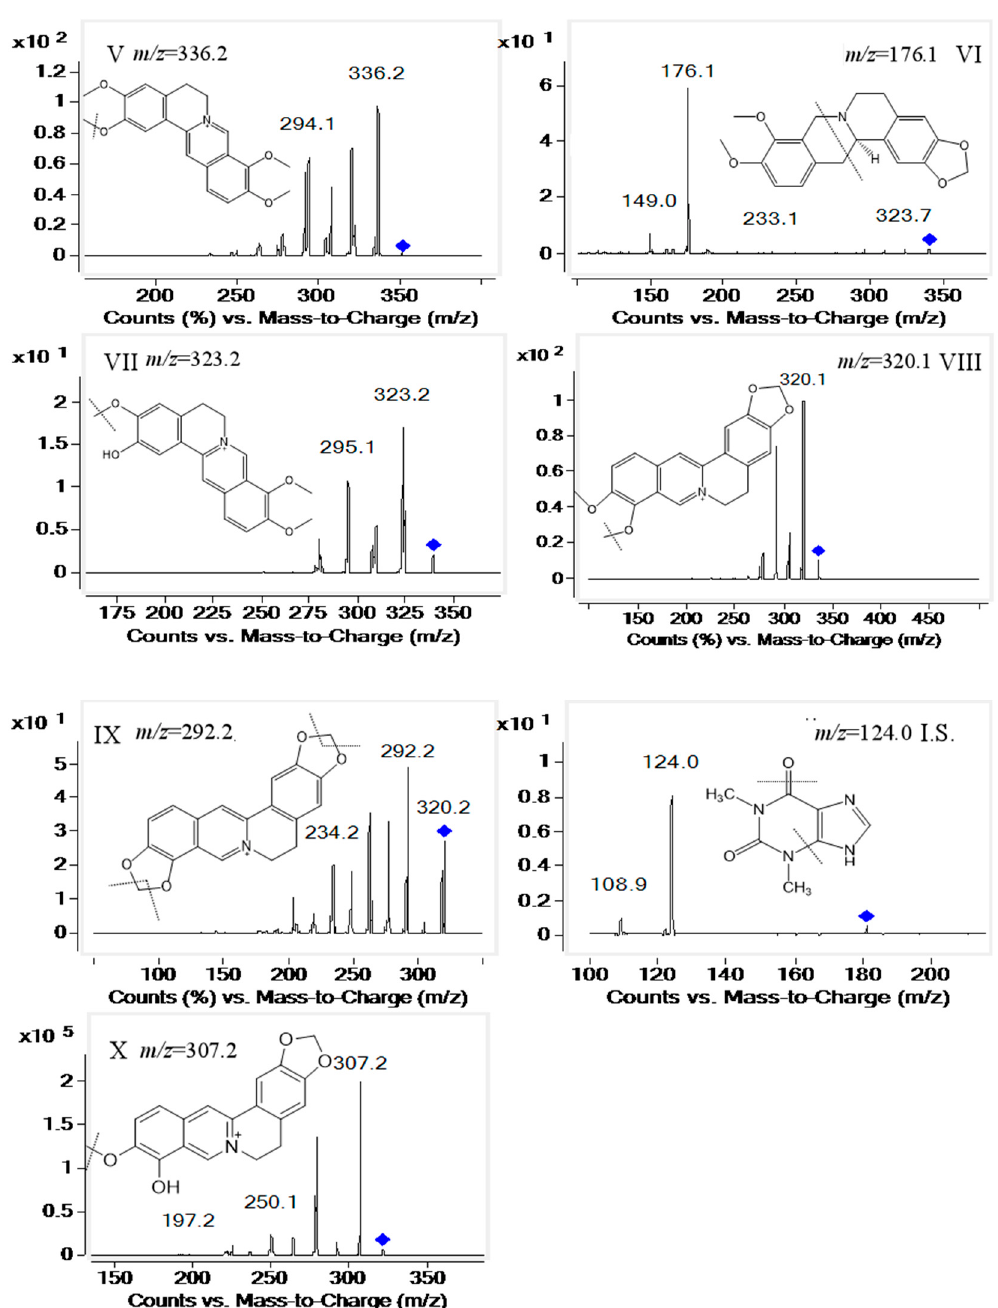
Figure 1. Product ion mass spectot of corydaline ( I ), dehydrocorydaline ( II ), tetrahydropalmatine ( III ), protopine ( IV ), palmatine ( V ), tetrahydroberberine ( VI ), columbamine ( VII ), berberine ( VIII ), coptisine ( IX ), berberrubine ( X ) and theophyline ( I.S .) in the postive mode.